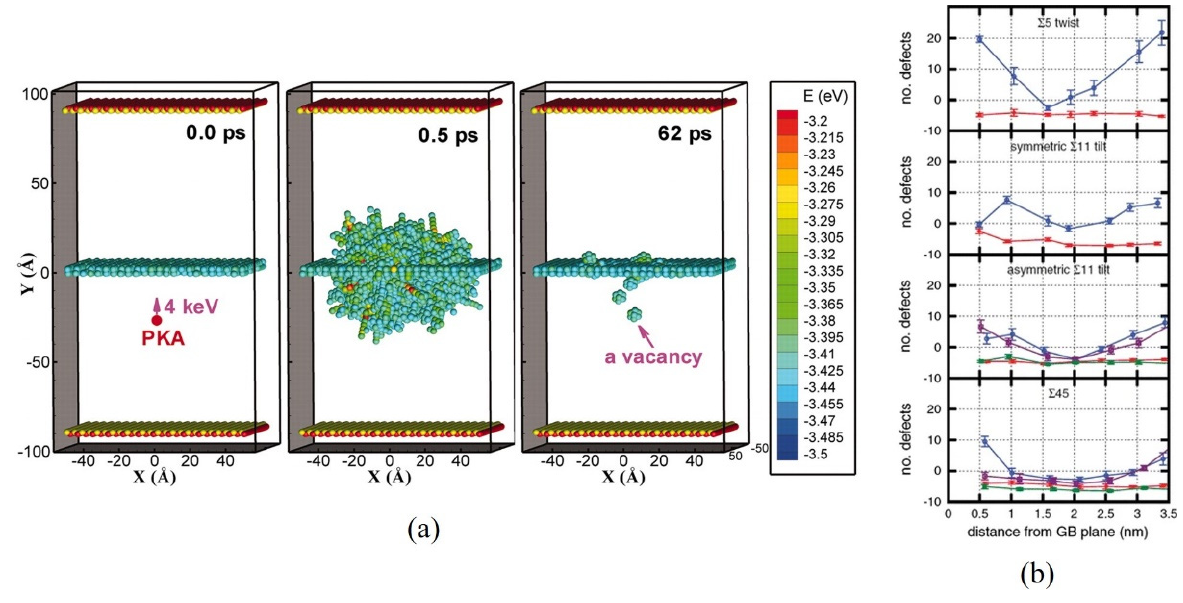
Figure 2. ( a ) Snapshots of an MD simulation of a collision cascade near a Σ 11{131} symmetric tilt GB at 300 K. The atoms are colored by their potential energy. The atoms are colored by their potential energy. Atoms with energies less than 3.43 eV are removed to highlight the structural defects. ( b ) The number of interstitials and vacancies surviving in the bulk region near four types of GBs after 4 keV collision cascades at 300 K. The numbers are relative to the number of Frenkel pairs produced in equivalent cascades in single crystals. The symbol colors represent the following: blue—vacancy numbers for PKAs initiated in the lower grain; red—interstitial numbers for PKAs initiated in the lower grain; purple—vacancy numbers for PKAs initiated in the upper grain; green—interstitial numbers for PKAs initiated in the upper grain. Reproduced with permission from Refs. [4,36]. Copyright 2021 American Physical